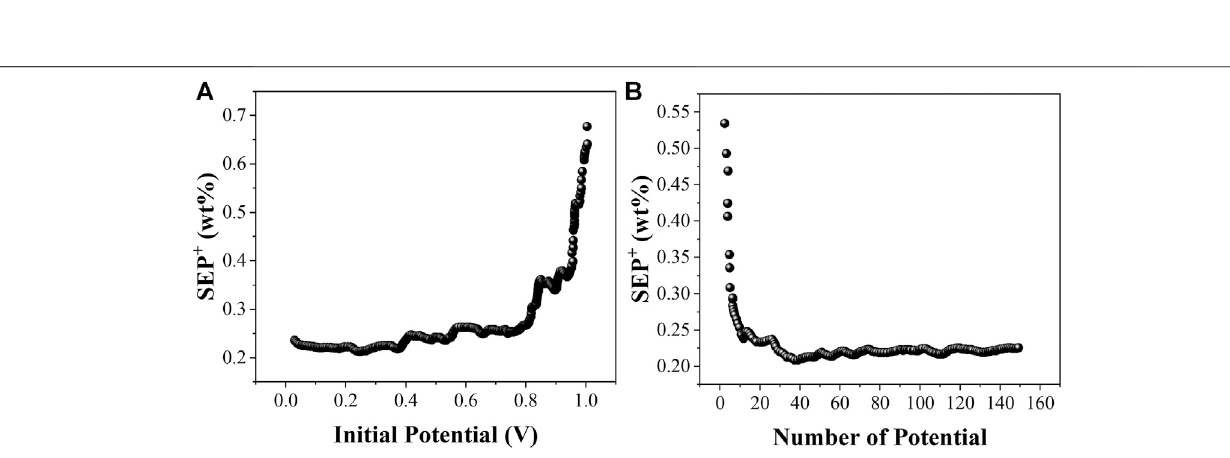
Frontiers in Chemistry |